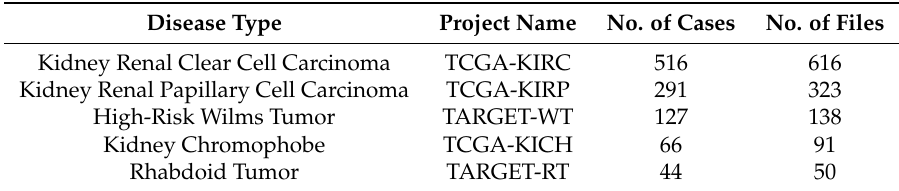
Figure 2. Kidney diseases projects available in the The Cancer Genome Atlas (TCGA) data repository. Table 1. Table Type